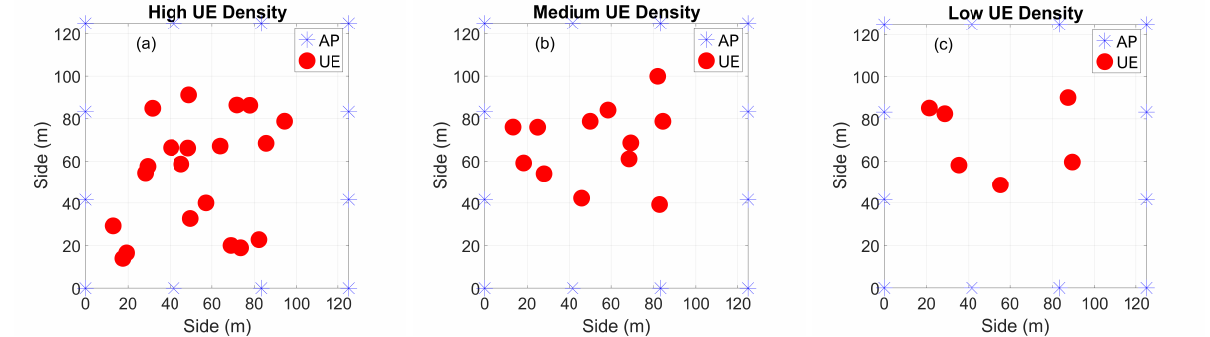
Figure 1. AP and UE positions in a high ( a ) medium ( b ) and low ( c ) UE density RS